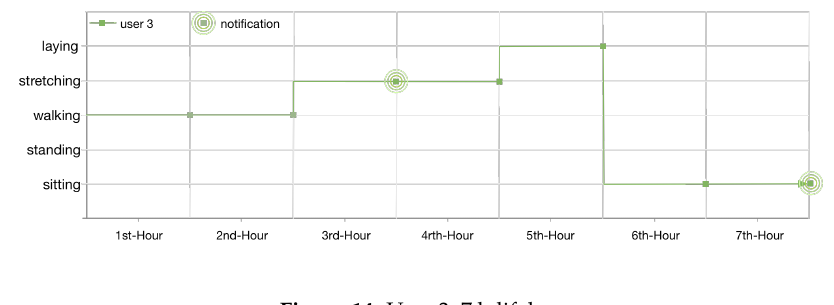
Figure 14. User 3, 7 h lifelog.